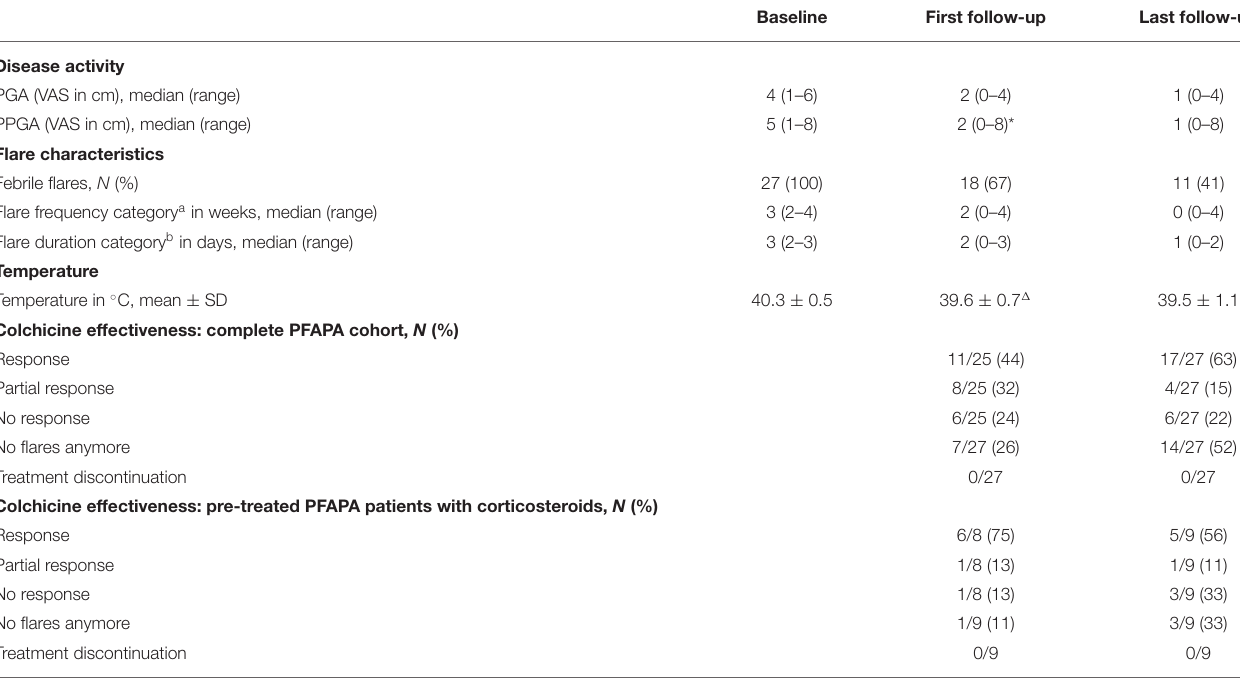
Baseline First follow-up Last follow-up